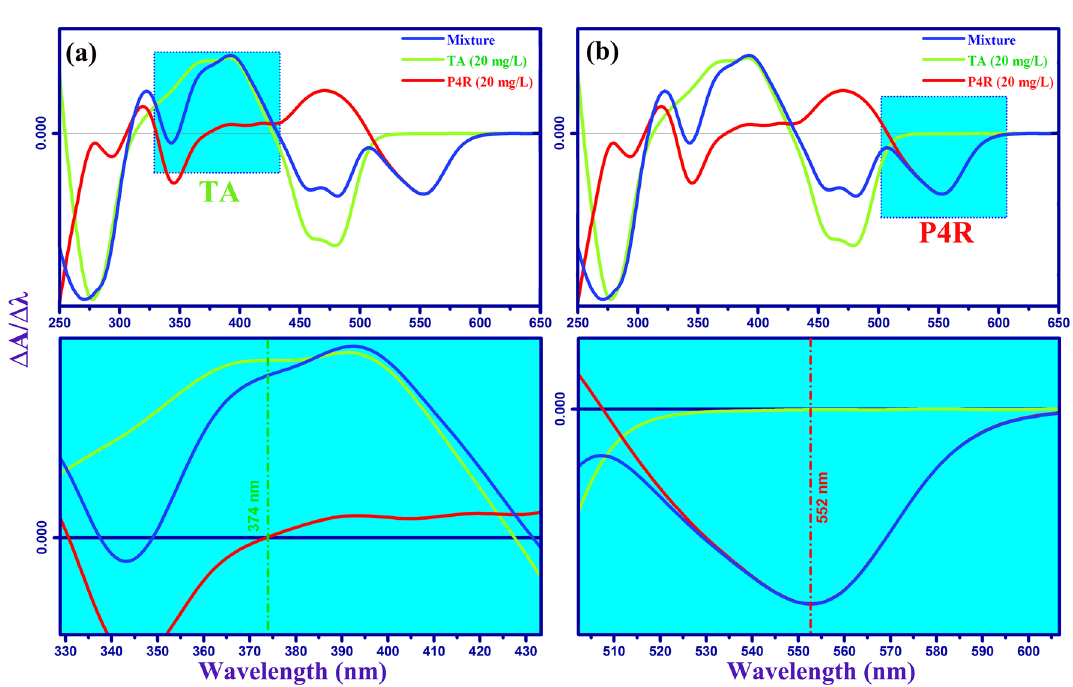
Figure 2. The representative first order derivative spectrum of TA ( a ), P4R ( b ), and mixture of dyes in aqueous